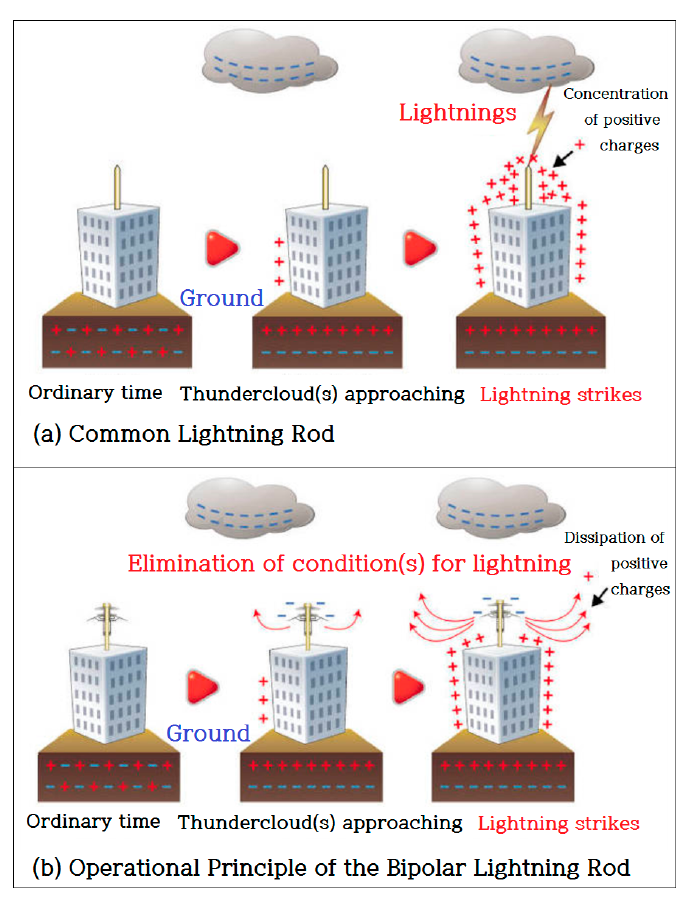
Figure 3. A common lightning rod and the operational principle of the bipolar lightning rod.